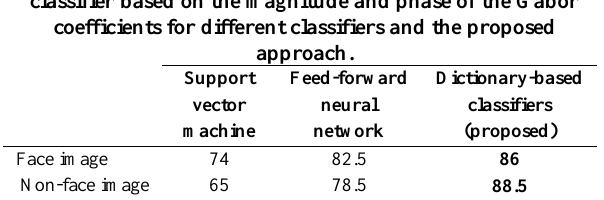
Table 5. Accuracy percentages of face/non-face image classifier based on the combination of magnitude and phase of Gabor coefficients with PCA for neural network, support vector machine, and the proposed dictionary- based classifier.